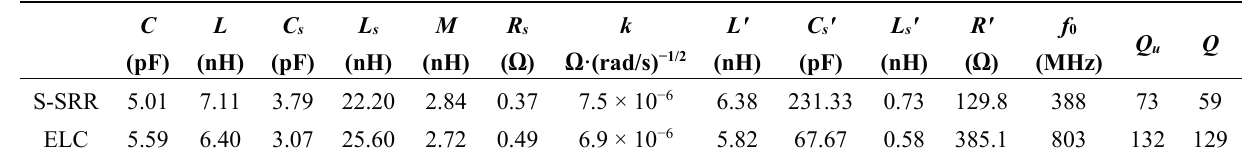
Table 1. Extracted circuit elements of the models in Figure 5 for the ELC- and S-SRR-loaded CPWs of Figure 6 with 90° orientation.